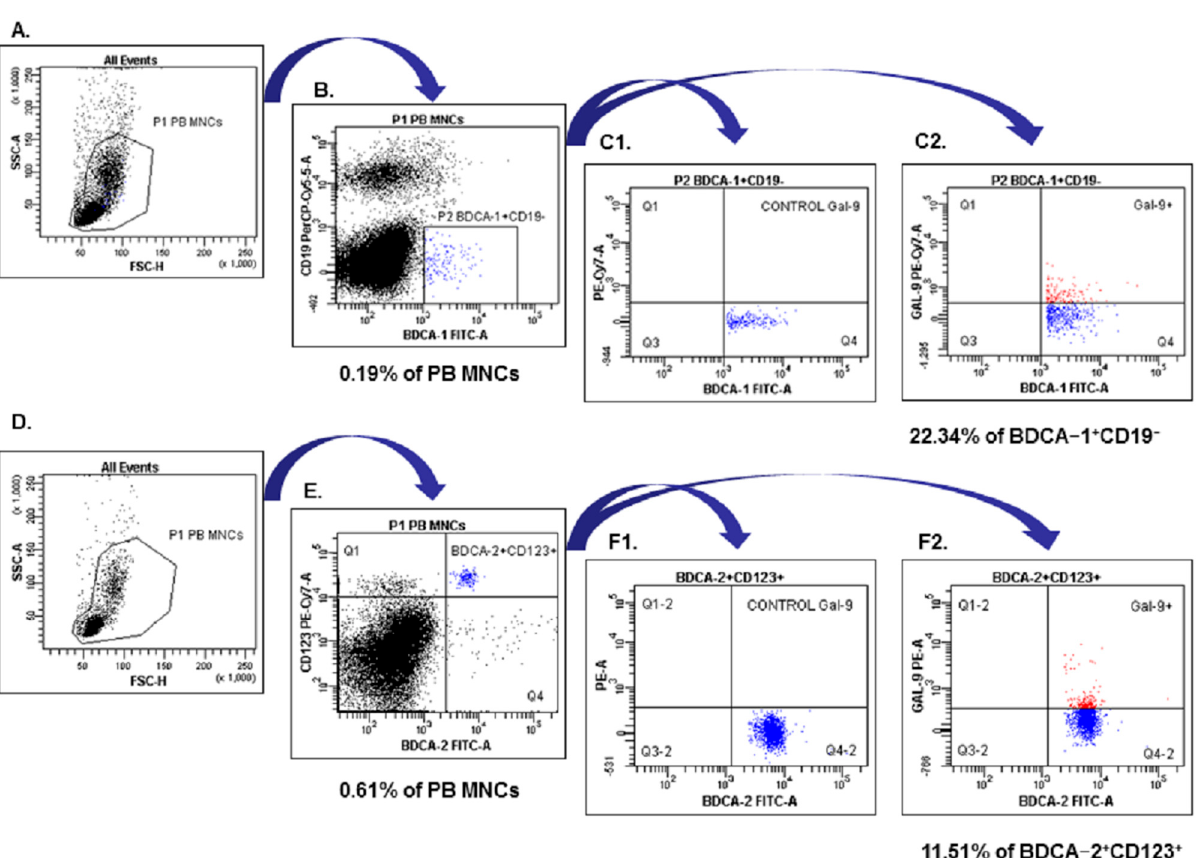
Figure 11. Flow cytometric analysis of BDCA-1 + CD19 − and BDCA-2 + CD123 + dendritic cells with Gal-9 expression in the PB of the patient with EMS. An acquisition gate was established based on FSC and SSC that included mononuclear cells (P1